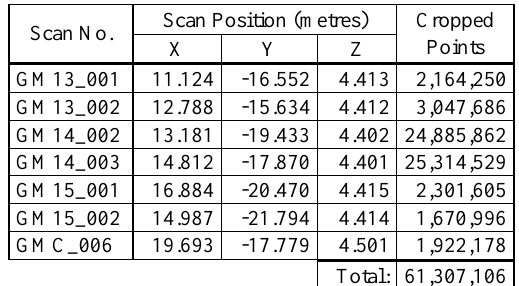
Table 2. Scan positions and number of points in E57 benchmark